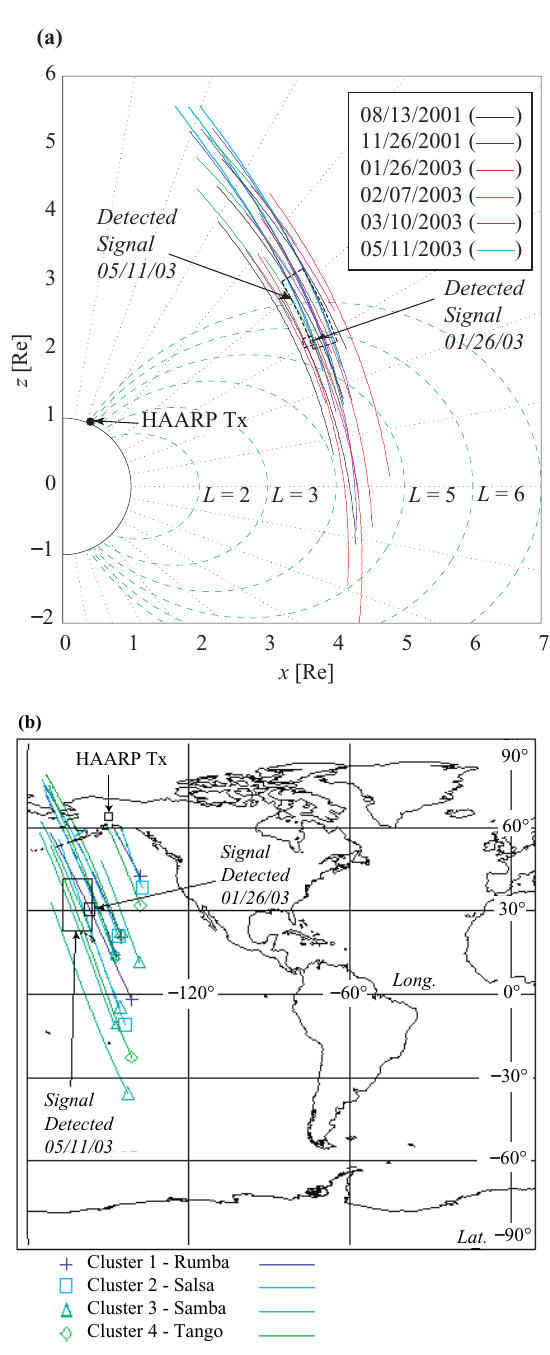
Fig. 1. Trajectories of the Cluster spacecraft during the dates when the HAARP-Cluster experiment was performed. (a) Projection of the spacecraft trajectories upon a meridional plane. Each color cor- responds to a different day, as highlighted in the legend box. Mag- netic coordinates are based on the centered dipole model. (b) Ge- ographic projection of the spacecraft trajectories. Each color cor- responds to a different spacecraft, as highlighted in the legend box. The dashed line rectangles indicate the regions where the HAARP signal was detected for the two successful passes. All the trajecto- ries were in the south-to-north